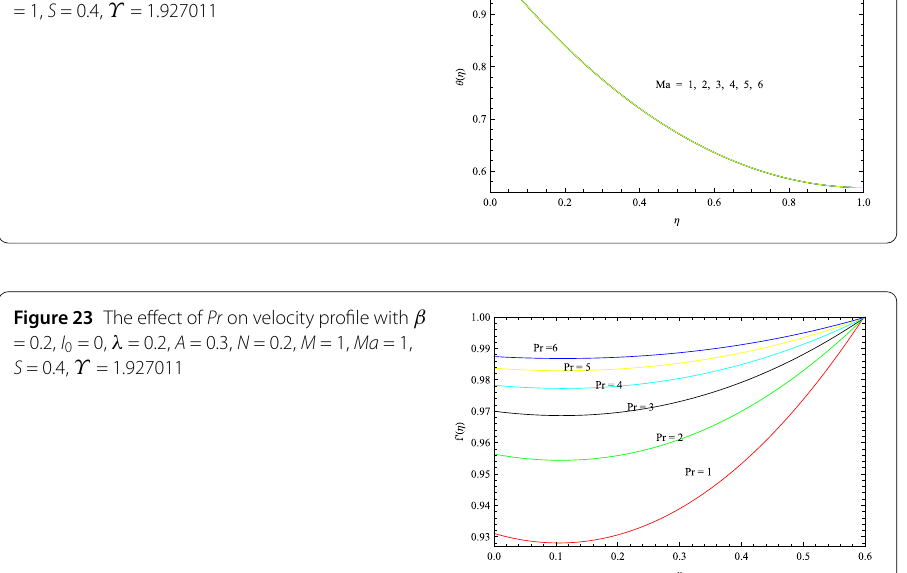
Figure 22 The effect of Ma on temperature profile with β = 0.2, I 0 = 0, λ = 0.2, A = 0.3, N = 0.2, M = 1, Pr = 1, S = 0.4, Υ = 1.927011